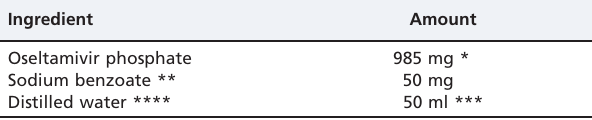
Table 1 - Composition of the Oseltamivir bottles defined by the Central Pharmacy of Hospital das Clı´nicas.